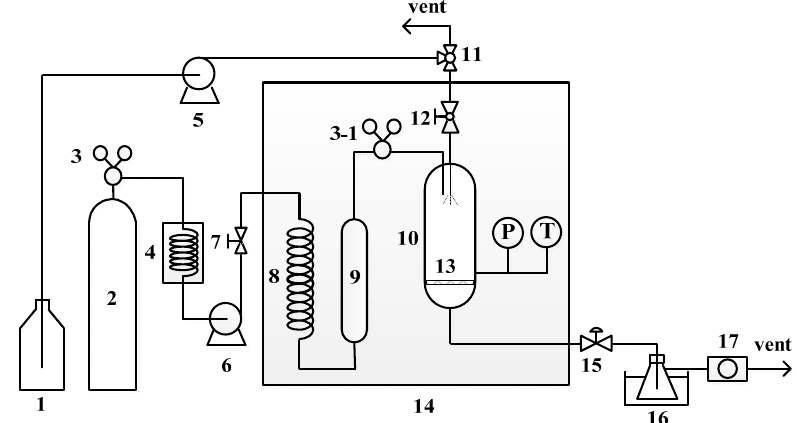
Figure 1. Schematic diagram of apparatus for compressed CO 2 antisolvent operation: (1) PBT/HFIP solution tank, (2) CO 2 cylinder, (3) regulator, (4) cooler, (5) HPLC pump, (6) high-pressure pump, (7) needle valve, (8) coil, (9) surge tank, (10) precipitator, (11) three-way valve, (12) ball valve, (13) filter, (14) oven, (15) metering valve, (16) cold bath, and (17) wet gas meter.